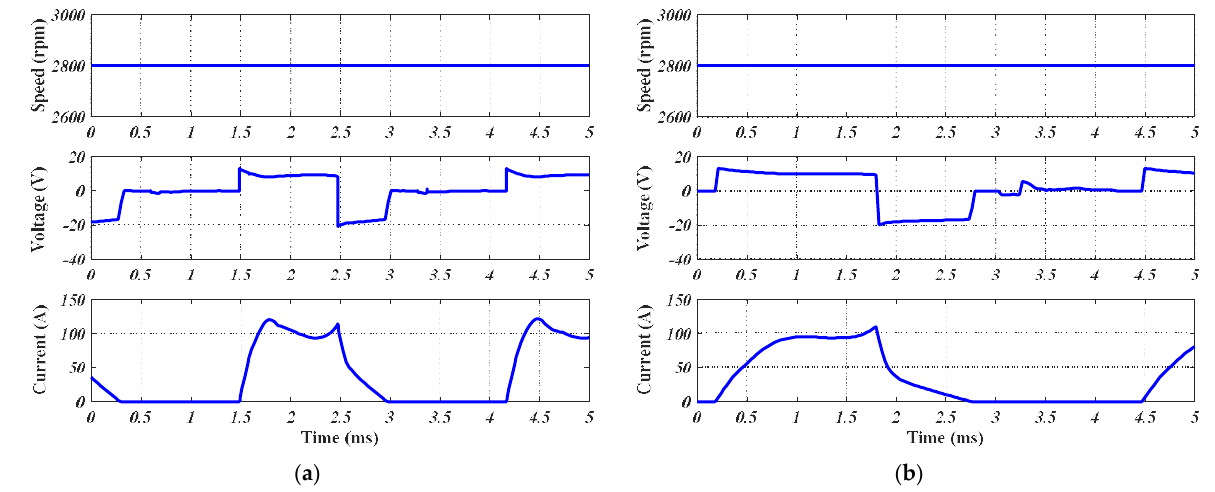
Figure 13. Simulation results under rated operating conditions. ( a ) Traditional 12/8 SRM; ( b ) Proposed 6/5 SRM.